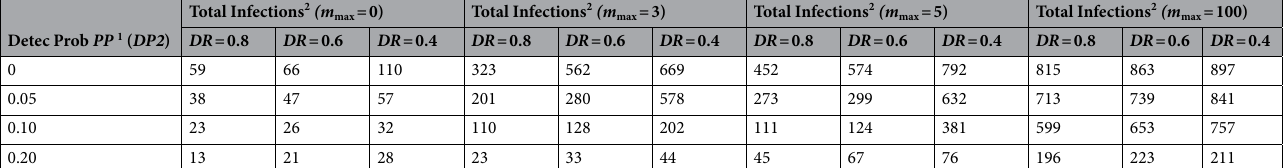
Table 3. Dependency of the number of infections on mobility restriction and detection probability during the presymptomatic phase, and transmission probability (1000 people, 2000 sites, 0.8 transmission probability, restriction at 1%). Total number of infection for DR2 = 0 to 0.4. 1 DR2 : Detection probabilities at the presymptomatic phase. 2 Total number of infected people at the end of the